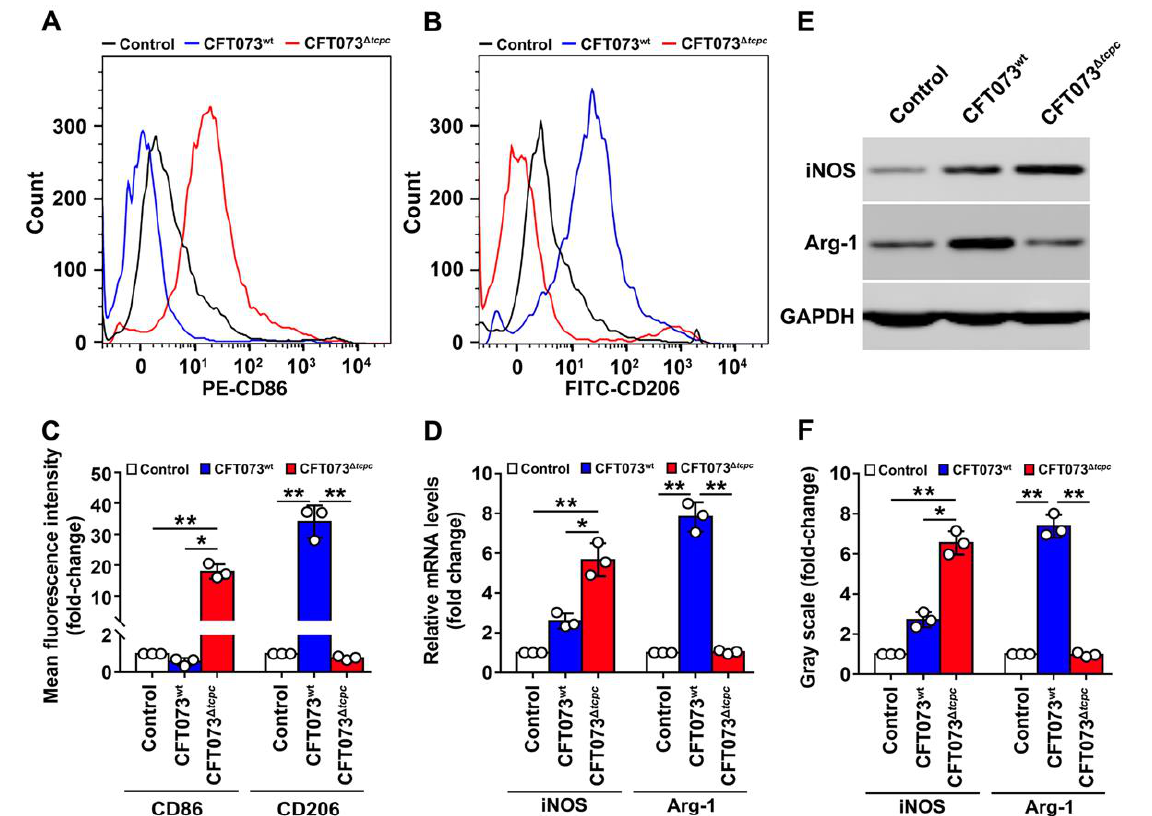
Figure 2. CFT073 wt infection significantly inhibits CD86 and iNOS but promotes CD206 and Arg-1 expression in K-macrophages from PN mouse models. ( A , B ) Flow cytometry analyses to examine the expression of CD86 and CD206 on K-macrophages. ( C ) FI of CD86 and CD206 were analyzed by FlowJo v10.0.7 software. FI in the control group was set as 1.0. ( D ) mRNA levels of iNOS and Arg-1 in K-macrophages were detected by qRT-PCR. ( E ) Protein levels of iNOS and Arg-1 in K-macrophages were detected by Western blot. ( F ) Gray-scale analyses of bands reflecting iNOS and Arg-1 protein levels in experiments as described in E. Gray scale in the control group was set as 1.0, Mean ± SD of three independent experiments are shown. * : p < 0.05; ** : p < 0.01.